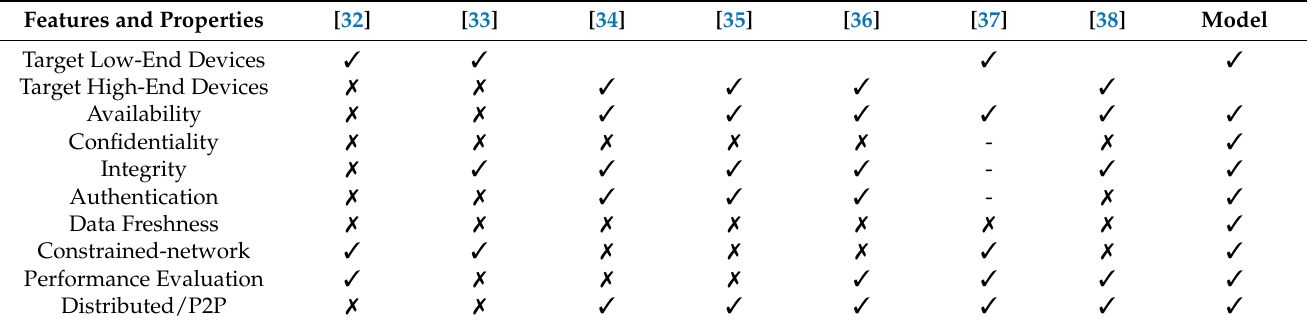
Table 13. Property Comparison of the Proposed Model and State-of-the-Art